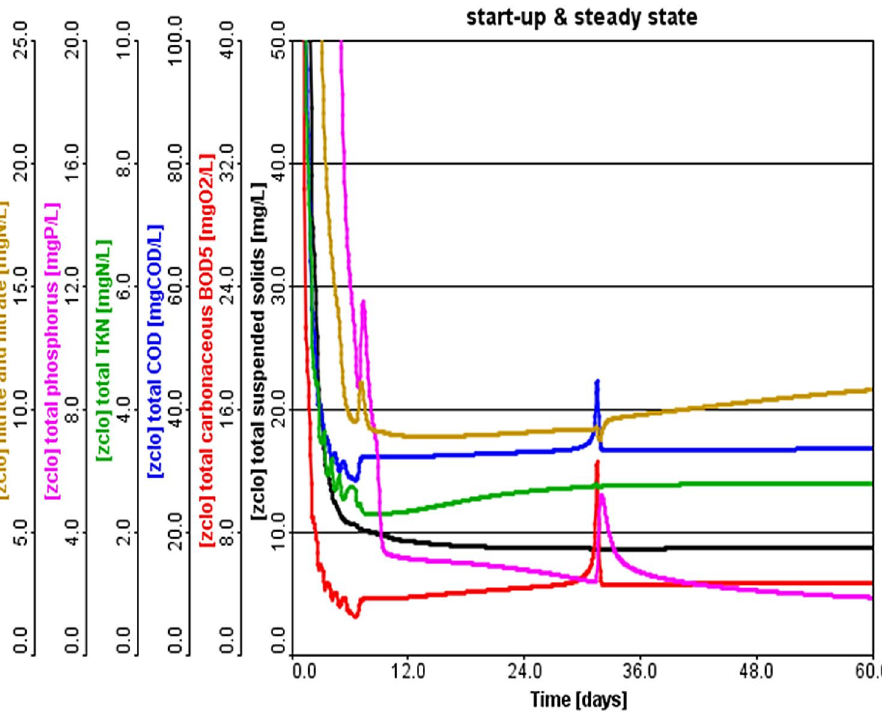
Figure 8. Performance evaluation of full scale A 2 /O system without sidestreams returning.